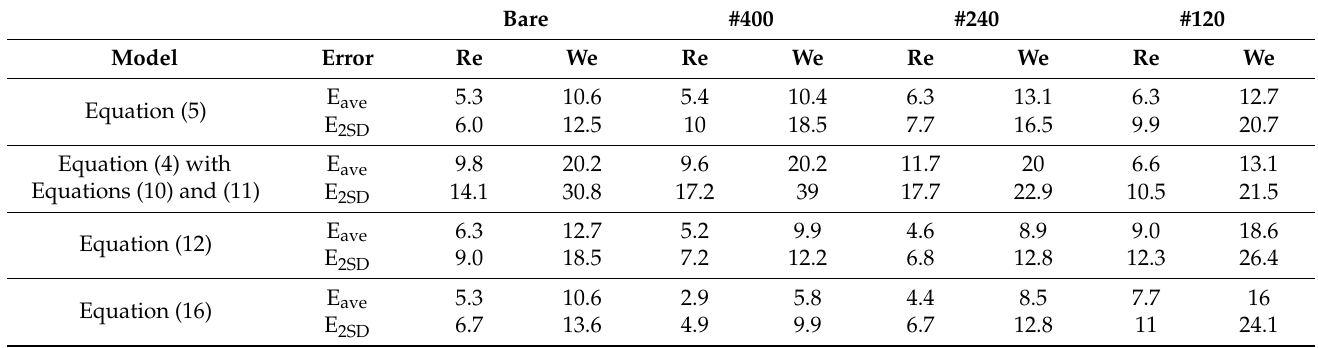
( c ) ( d ) Figure 16. Comparison of experimental value for Re c with the predicted one in each model: ( a ) bare substrate; ( b ) #400 substrate; ( c ) #240 substrate; and ( d ) #120 substrate. The green, black, red, and blue symbols are predicted by Equation (5), Equation (4) with Equations (10) and (11), and Equation (12) and Equation (16), respectively. Table 4. Accuracy of each model. E ave indicates the averaged values over all the kinds of liquid cases for the relative error E n-wt% = 100|( x exp − x pre )/ x exp | n-wt% (%). E 2SD indicates the two standard deviation for the errors over all the kinds of liquid cases: x corresponds to We c or Re c